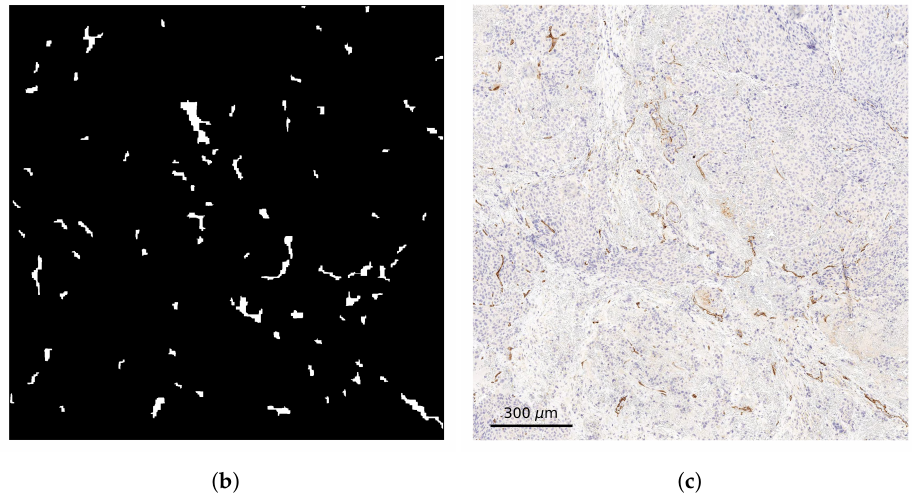
Figure 1. ( a ) Example of the used tissue microsection immunohistochemically stained for CD31 (vessel endothelium). The red square represents one of the regions of interest used for simulations. ( b ) Region of interest after binarization. ( c ) Zoom image of the